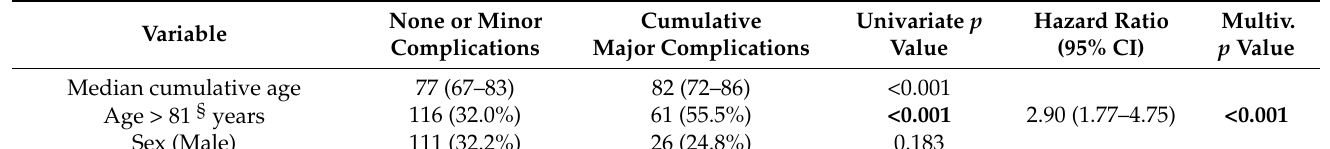
Table 3. Univariate and multivariate analysis for major cumulative complications #